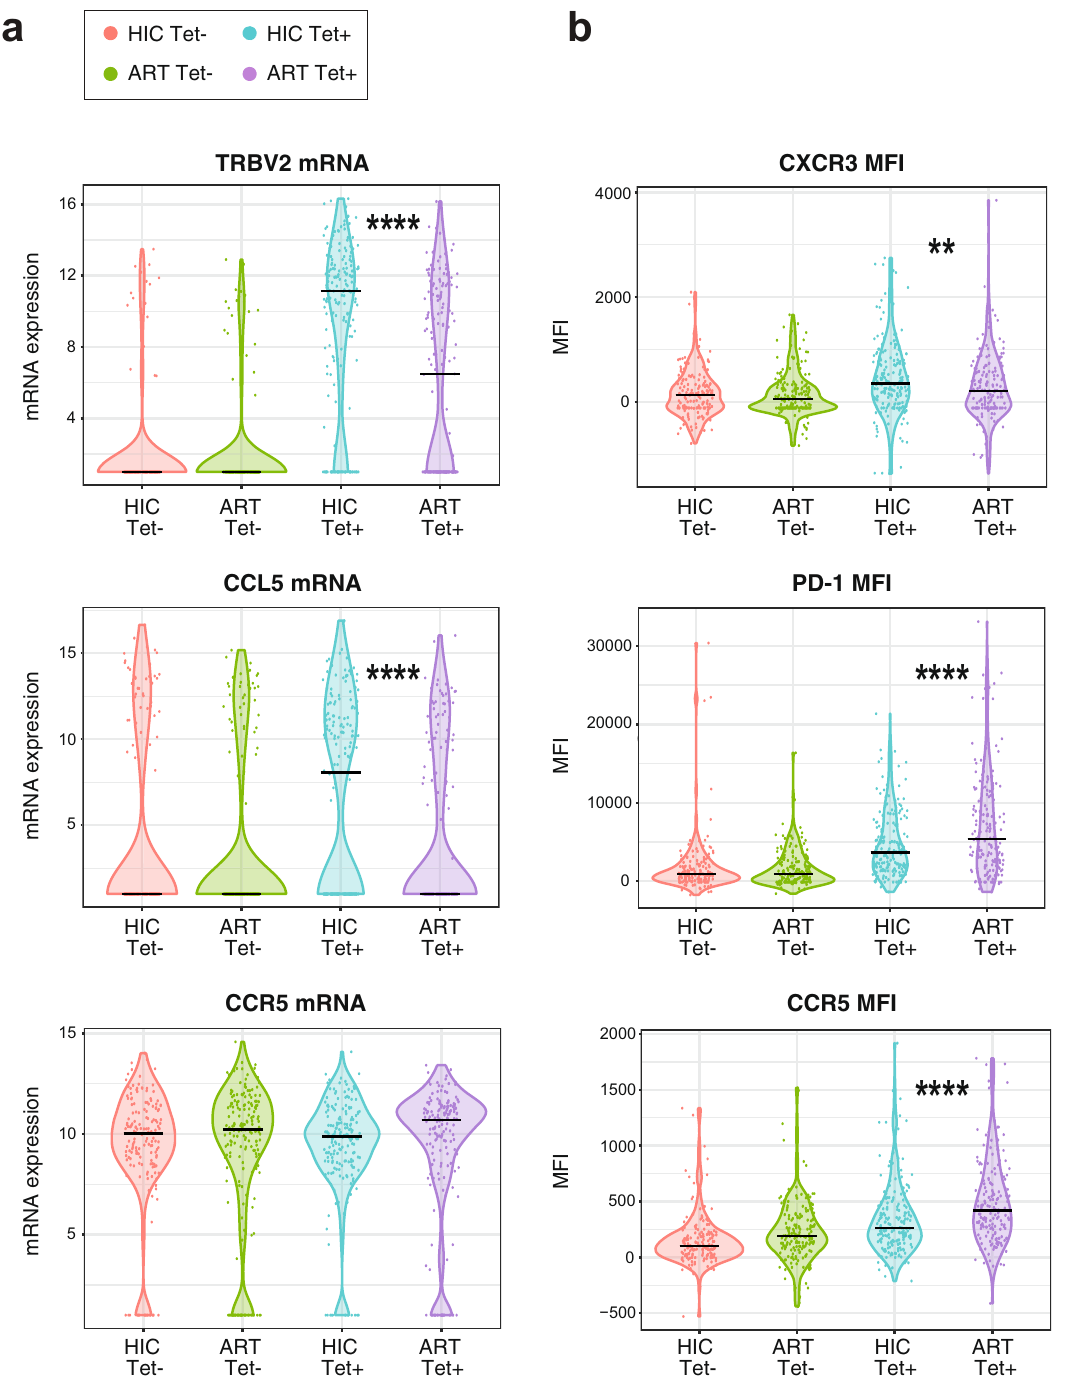
Fig. 2 Gag293-speci fi c cells of controllers are characterized by high CCL5 but low CCR5 expression. a , b Distribution of gene expression values ( a ) and protein MFI ( b ) for selected variables in the 4 single cell groups (HIC Tet + n = 188, HIC Tet − n = 160, ART Tet + n = 170, ART Tet − n = 182). Signi fi cant P values measured by a Mann-Whitney test between the HIC Tet + and ART Tet + groups are indicated by stars (** P < 0.01, **** P <